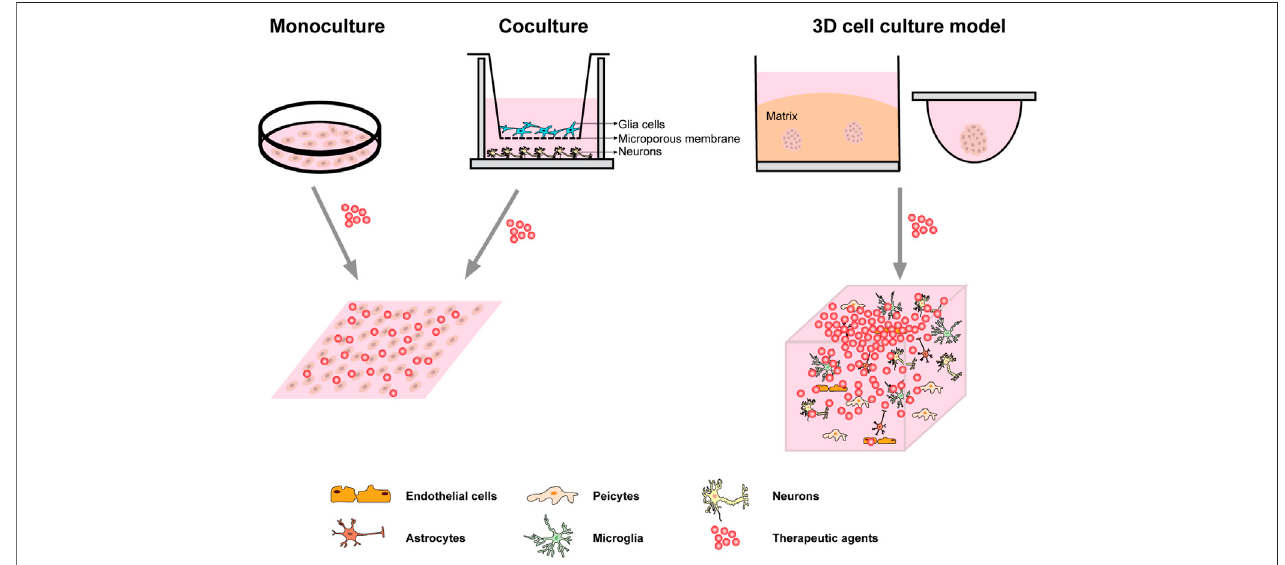
FIGURE 1 | Common cell culture system. Monoculture is usually carried out directly on the rigid plastic culture substrate; A common use of co-culture is to grow both types of cells in the same extracellular fl uid using Transwell chambers; The fi rst two systems of culture were homogenous drug distribution when it comes to the treatment medium or the stimulation. The most commonly used 3D culture system is ECM embedded culture and static suspension culture. The neuro-spheroids or microscopic tissue model formed by 3D culture technology can better simulate the microenvironment in vivo , and the distribution gradient of drugs in vivo can be simulated more accurately when the treatment medium or stimulation is